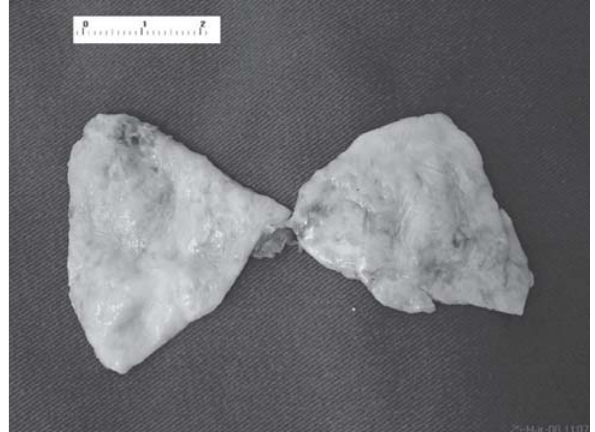
Fig. 4 - Peça cirúrgica (aorta torácica), demonstrando aspecto rugoso, de coloração amarelada, com espessamento de sua parede, o que sugere o quadro degenerativo da raiz da